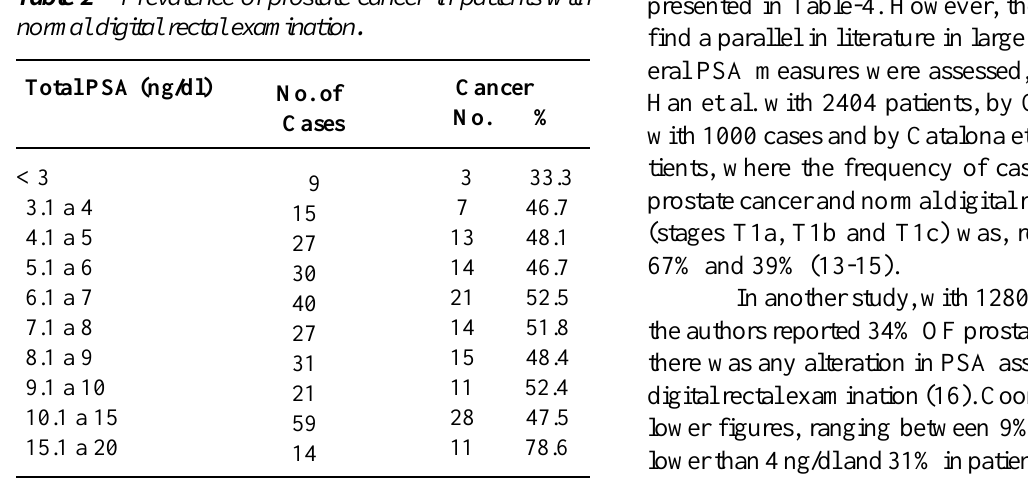
Table 3 – Incidence of prostate cancer in relation to various PSA parameters for indicating biopsy . PSA Parameters